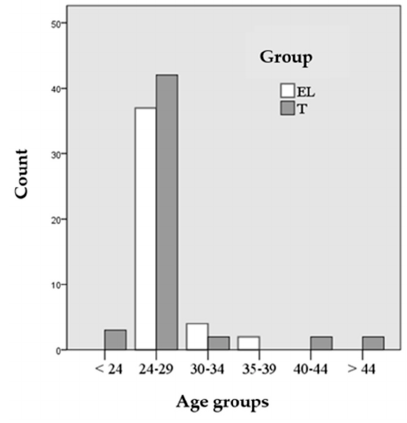
Figure 1. Age groups of students.